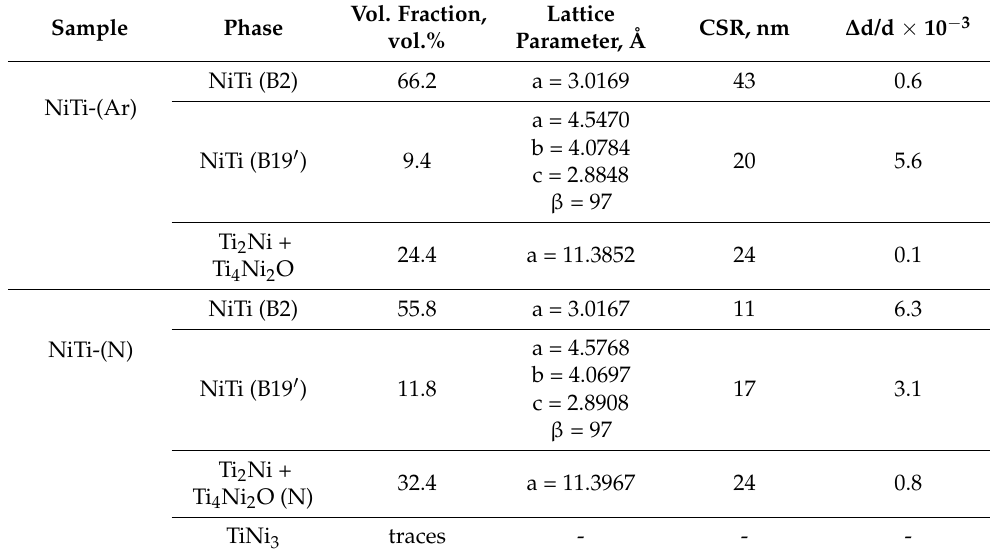
TiNi 3 traces - - - traces - - - Error in determination of the phase content ± 2 Error in determination of the phase content ±2 vol.%.